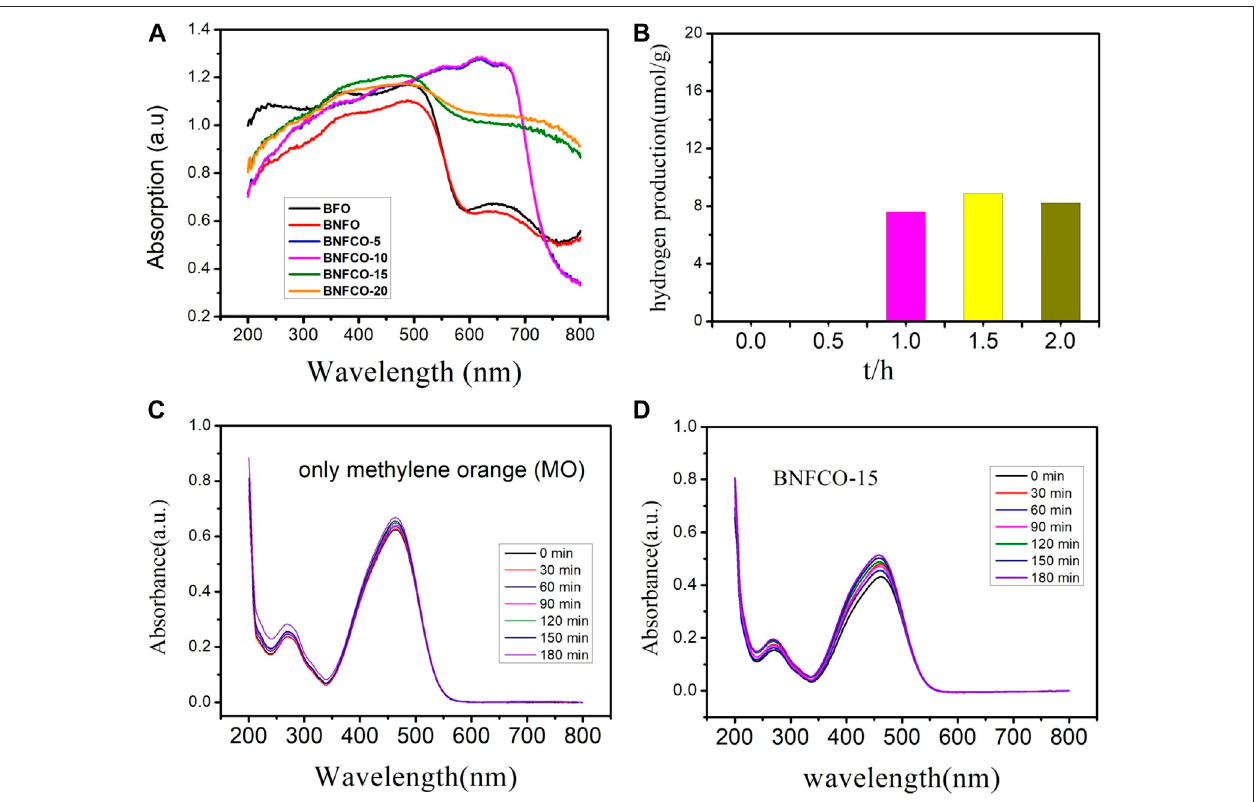
FIGURE 5 | (A) UV-vis absorption spectra of the Bi 1-x Nd x Fe 1-y Co y O 3 nanoparticles, (B) Dependence of hydrogen production on irradiation time in the photocatalyticprocesswiththepresenceofBNFCO-15, (C) AbsorptionspectraofmethyleneorangeintheabsenceofBNFCO-15, (D) Absorptionspectraofmethylene orange in the presence of BNFCO-15.